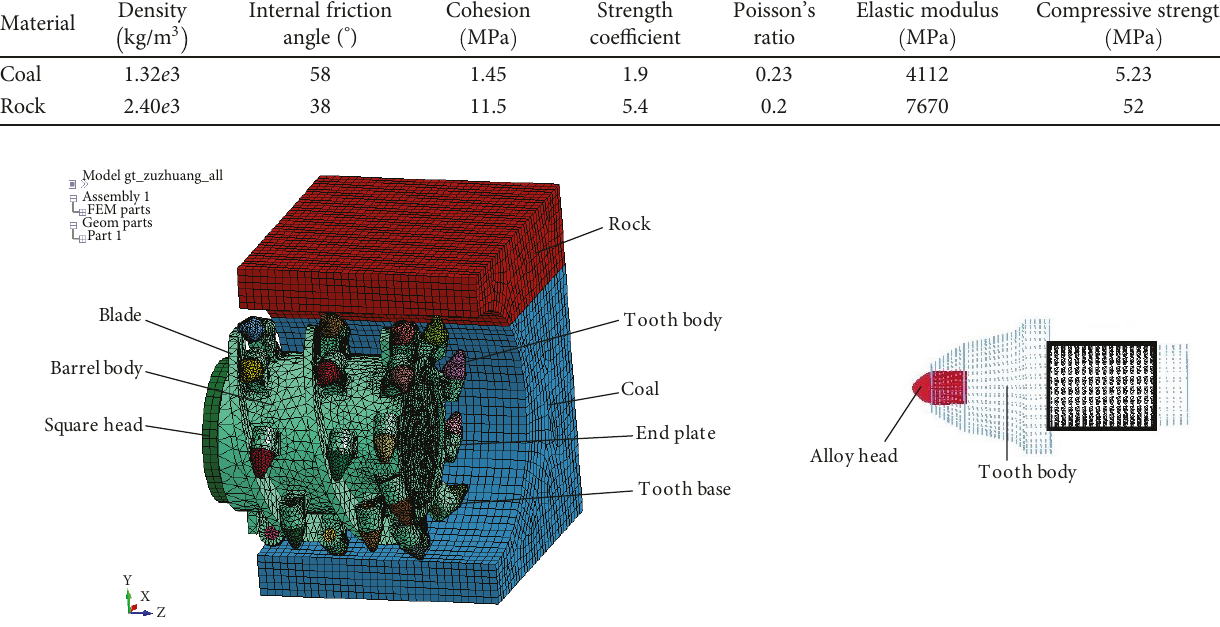
Figure 2: Finite element model of the roller and coal rock.